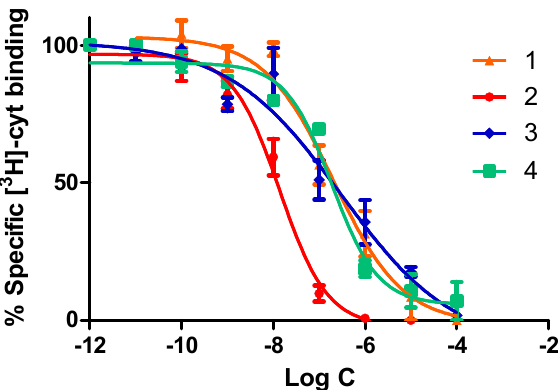
Figure 4. E ff ects of phenylpyrrolidine derivatives on binding of [ 3 H]cytisine to human α 4 β 2 nAChRs. Data points represent the mean ± SEM of four experiments. Each experiment was carried out in triplicate. The radioligand concentration in all displacement studies was 1 nM. The concentration-inhibition data was analyzed non-linearly.